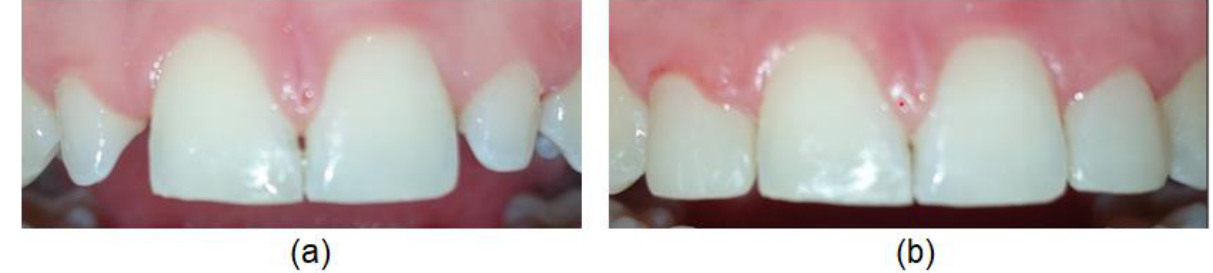
Figure 3. Reshaping the dental crown with composite by a restorative dentist: ( a ) before and ( b ) after buildup.